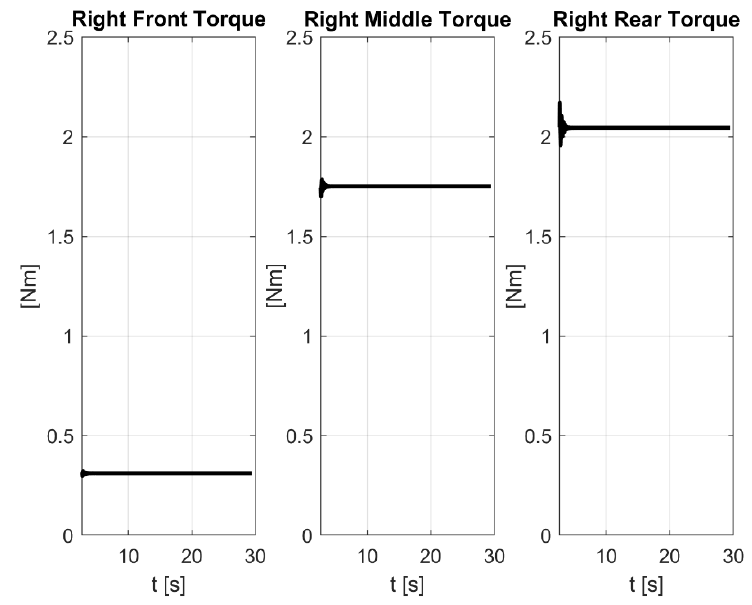
Figure 7. Torque values computed on right-side wheels in inverse dynamics simulations.